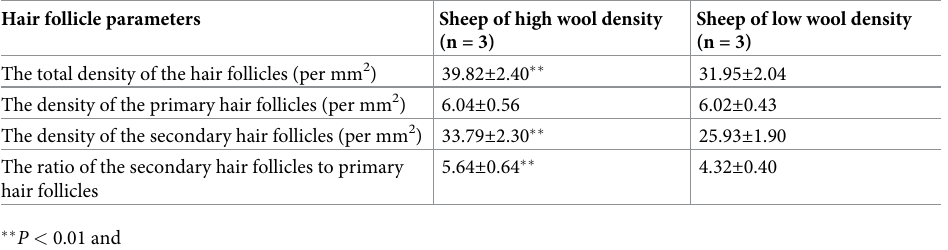
Table 2. Comparison of the parameters of the hair follicles of the Hetian